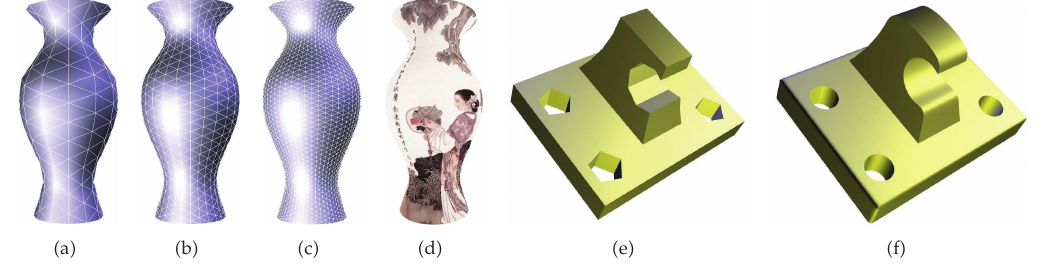
Figure 6: Modeling examples of the revolving